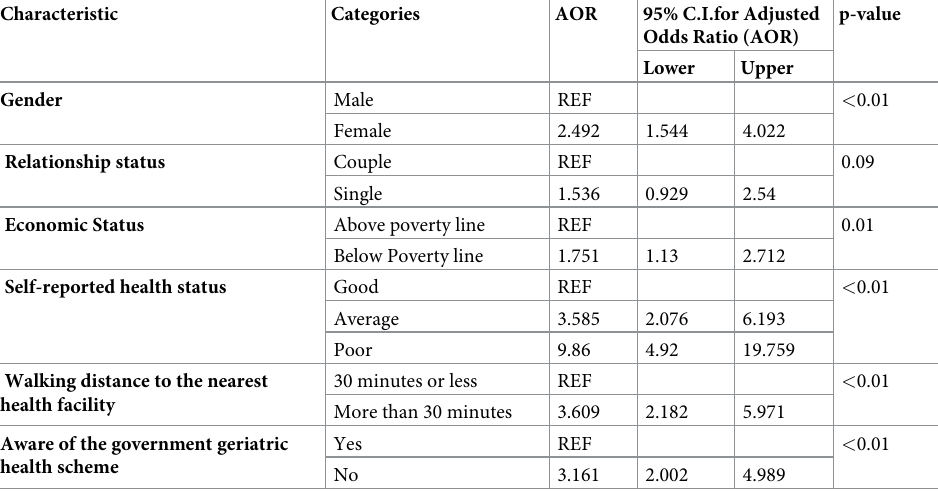
Table 5. Multivariable logistic regression analysis of different variables with difficulty in health-seeking behaviour.